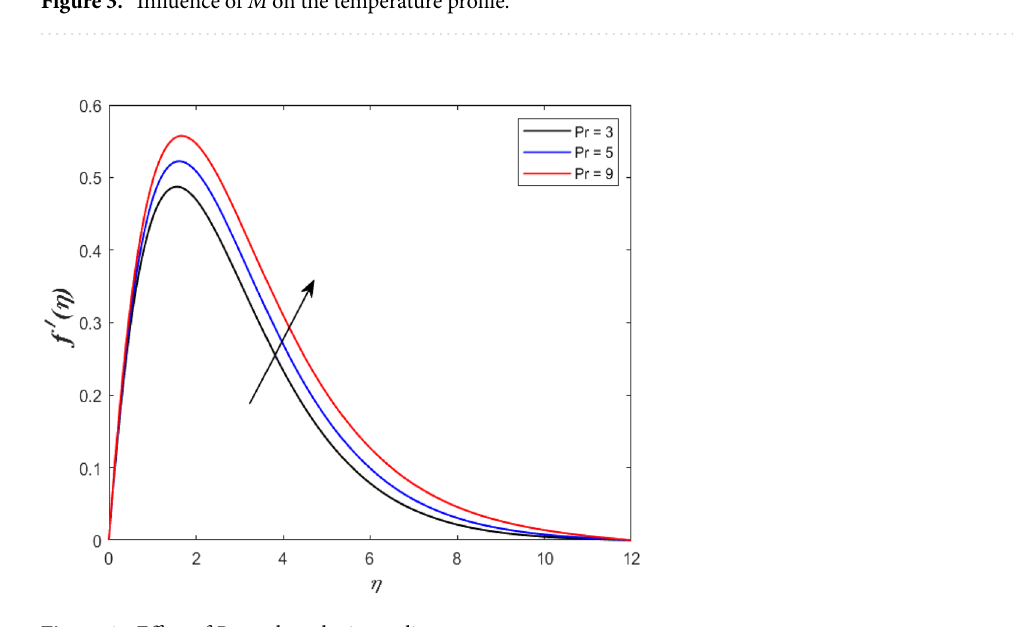
Figure 3. Influence of M on the temperature profile.